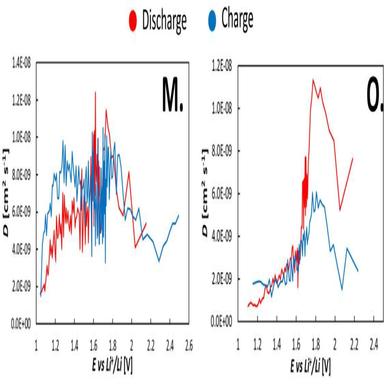
Diffusion coefficient vs electrochemical potential, for monoclinic and orthorhombic FeNb11O29.